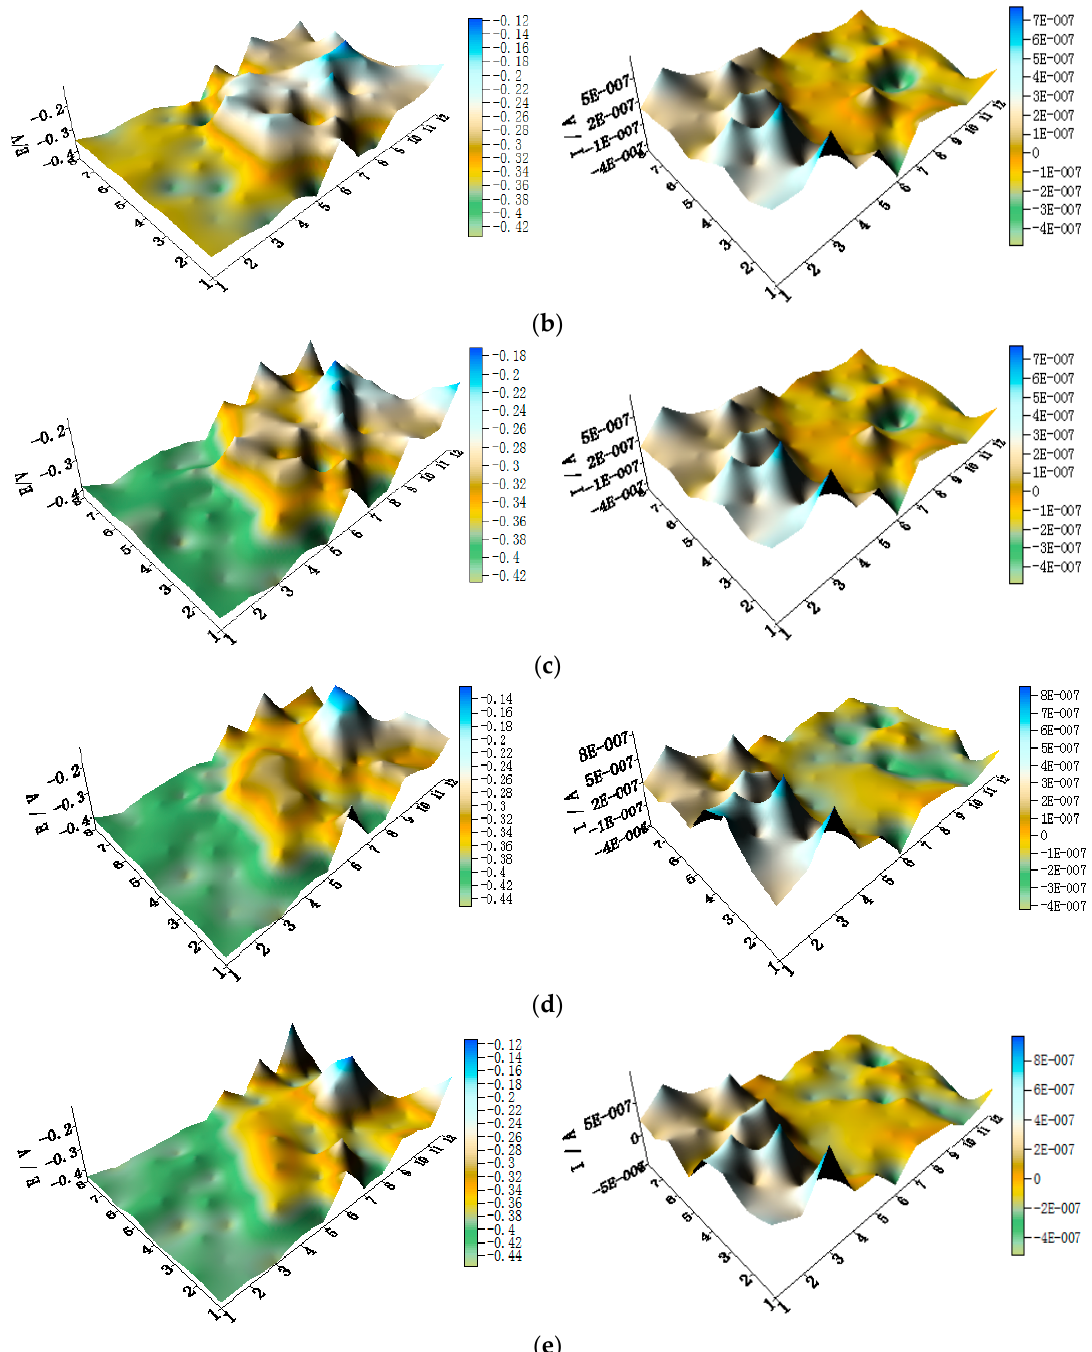
Figure 5. Spatial potential ( left , E vs. SCE/V) and current–density ( right , I/A) distribution maps of WBE1 after being short-circuited for 12 h in artificial seawater at different temperatures: ( a ) 30 °C; ( b ) 40 °C; ( c ) 50 °C; ( d ) 60 °C; and ( e ) 70 °C.